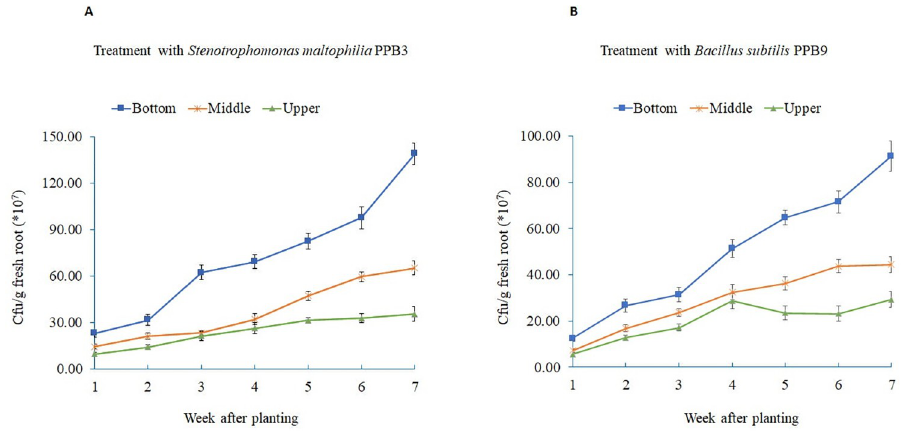
Fig 5. Population of Stenotrophomonas maltophilia PPB3 and Bacillus subtilis PPB9 in the upper (toward stem) (top), middle, and lower (toward root tip) (bottom) segments of 1-, 2-, 3-, 4-, 5-, 6- and 7-week-old tomato seedlings . Seeds were treated with the bacteria and were grown in pots for 12 weeks. Roots were harvested at 1, 2, 4, 5, 6, and 7 weeks after sowing and cut into the top, middle, and bottom regions. Root tissues of each segment were separately homogenized in sterilized distilled water. Appropriate dilutions of the homogenates were plated onto Yeast Peptone Agar (YPA) media. The plates were incubated overnight at 28˚C, and the number of colony-forming units (CFU) per gram of root tissue was determined. Data are presented as CFU g − 1 fresh weight, each from three sets of five roots harvested from three plants at each time